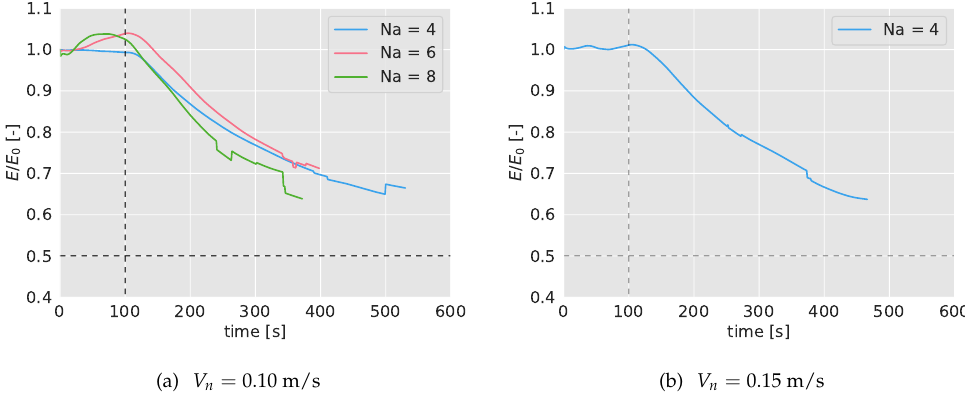
Figure 13. Efficiency of the algorithm over time when half of the agents are forced to land at t = 100s during the experiments, marked with a black dashed line. The efficiency has been normalized with the efficiency without quadcopter failures, E 0 . Note that the lines are uneven due to the different durations of the